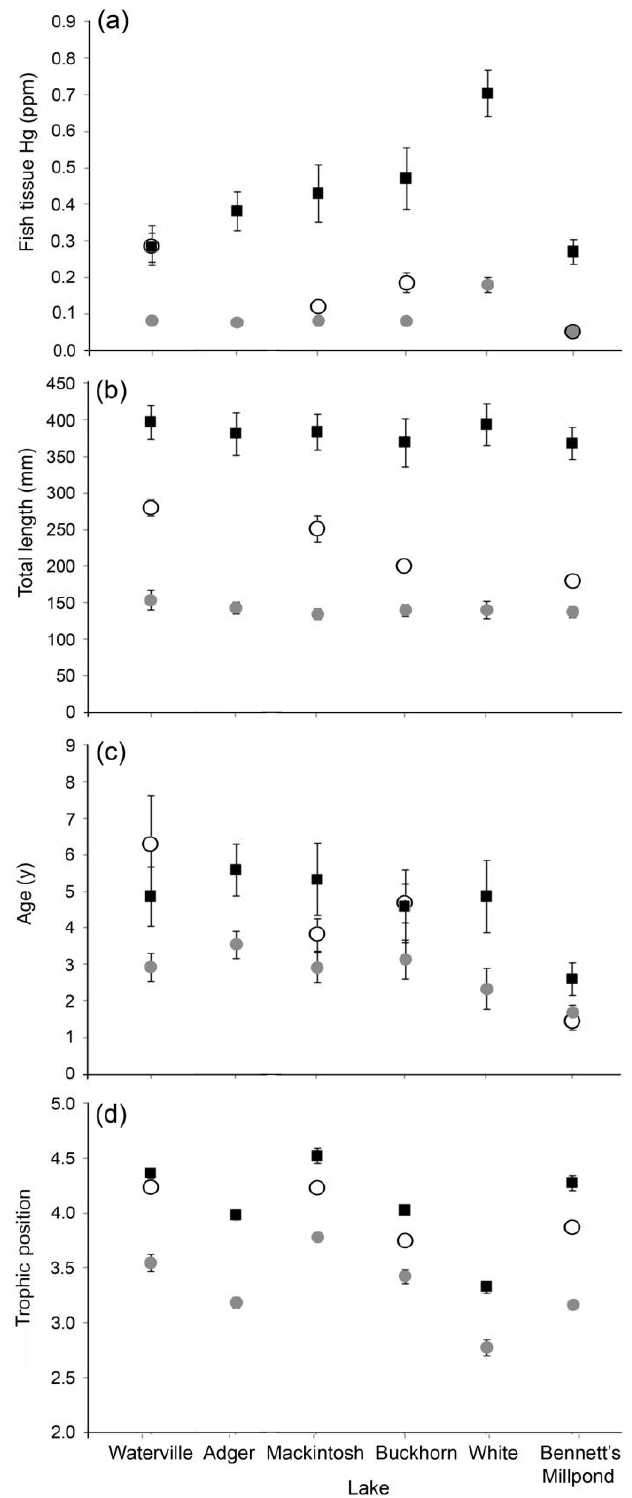
Figure 2. Means of ( a ) fish tissue Hg (ppm), ( b ) total length (mm), ( c ) age (years) and ( d ) trophic position (as measured by nitrogen isotopes) of bluegill (light grey circles), black crappie (open circles) and largemouth bass (dark squares) collected in four to six lakes in North Carolina, USA. Error bars indicate ± one standard error (hidden behind data symbols in some